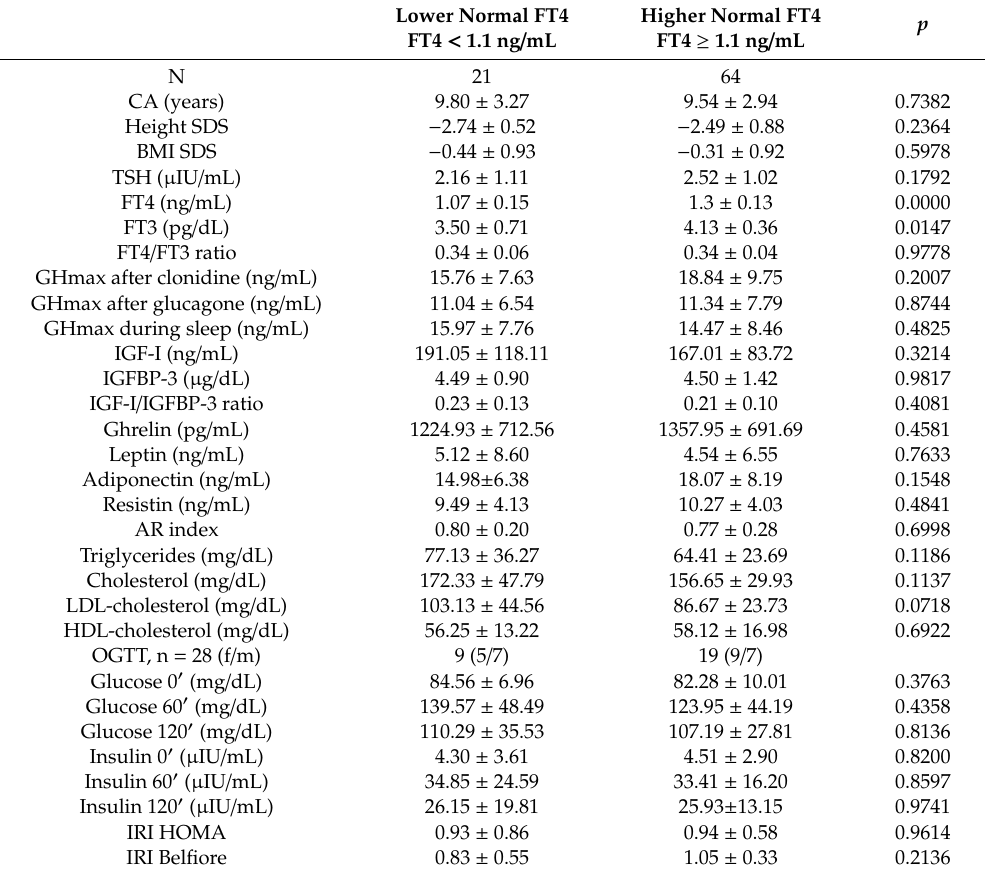
Table 2. The auxologic and biochemical parameters in children with ISS divided into two (2) groups distinguished by dependence on FT4 concentration: the first one—FT4 remaining in the lowest tercile of the reference range (i.e., below 1.1 ng / mL) and the second—FT4 equal to or being above the upper limit of lowest tercile - 1.1 ng / mL (i.e., FT4 within the middle or highest tercile of the reference